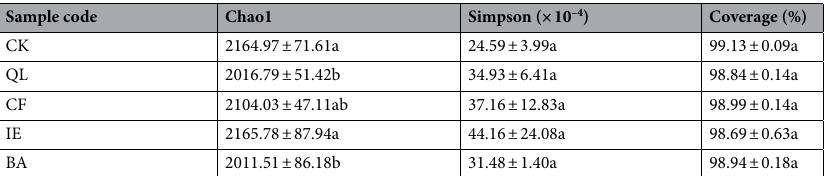
Table 2. Bacterial α–diversity of rhizosphere soil in continuous cropping lily. Date are presented as the Mean ± Standard Deviation (n = 3). Different letters within columns followed by indicate significance at p <